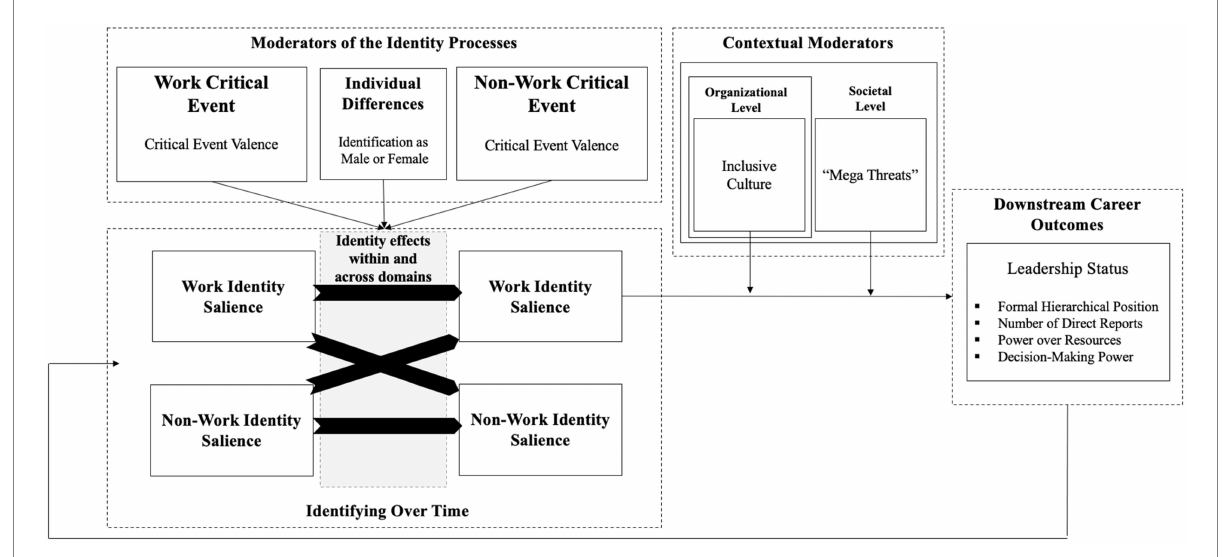
FIGURE 1 Overview of complete conceptual model. The block arrows represent